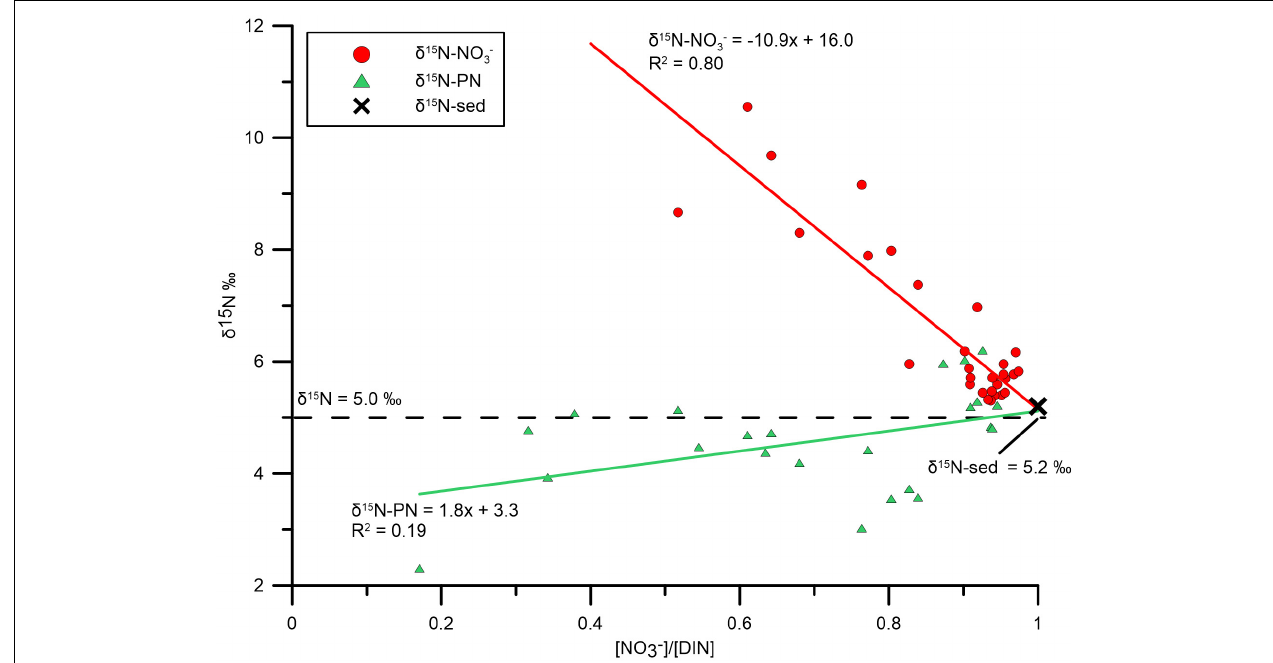
FIGURE 7 | [NO − 3 ]/[DIN] vs. δ 15 N-NO − 3 and [NO − 3 ]/[DIN] vs. δ 15 N-PN sampled from sYS. With proceeding nitrification, the values of δ 15 N-NO − 3 , δ 15 N-PN and δ 15 N-sed are converging. δ 15 N-sedi marked by a black cross is the average value for sediment of the sCW.